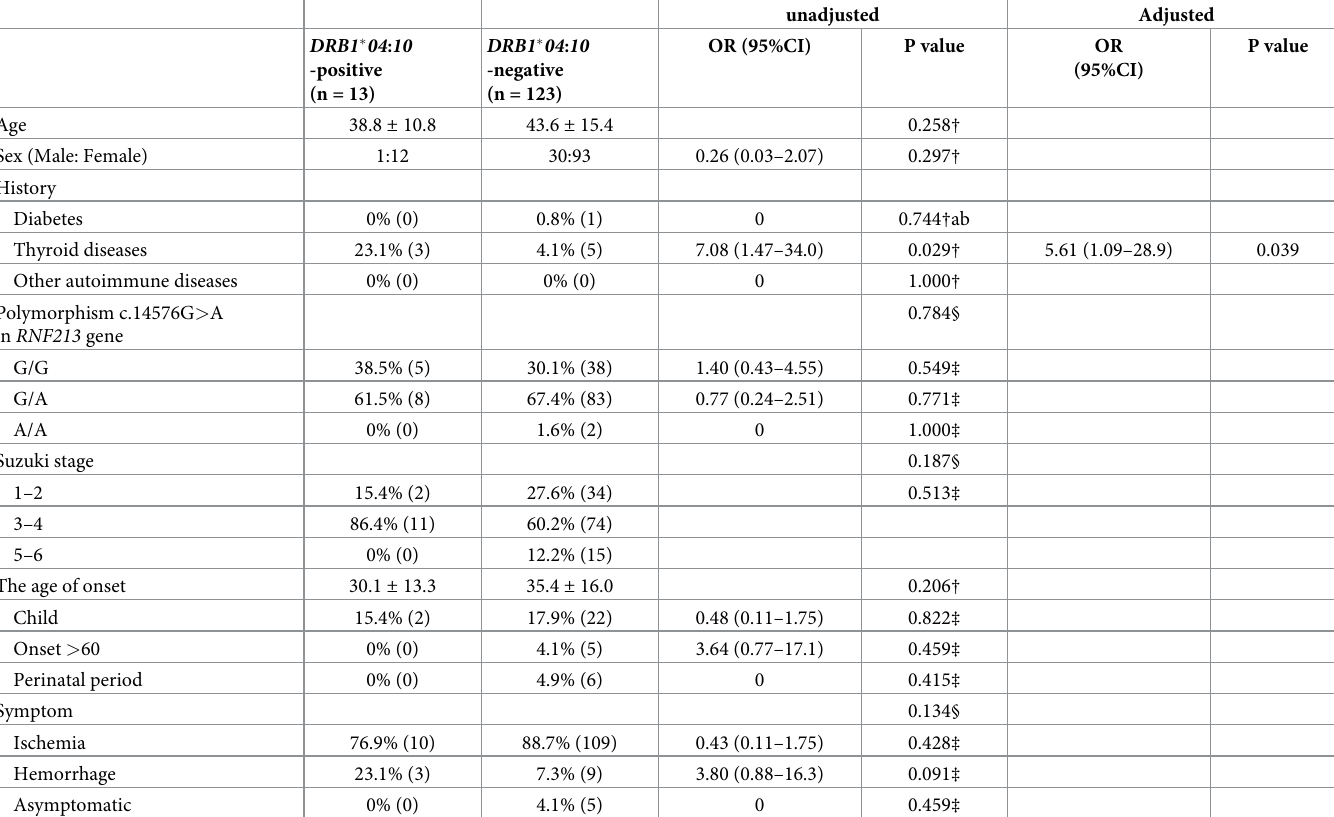
Table 5. Comparison of demographics between MMD patients with or without HLA-DRB1 � 04 : 10